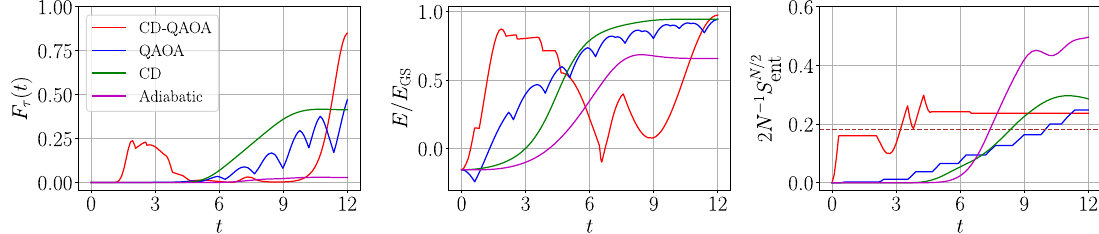
FIG. 24. Spin-1 Ising model: time evolution generated by the four different methods — CD-QAOA (red line), conventional QAOA (blue line), CD driving using the variational gauge potential (green line), and adiabatic evolution (magenta line). Three quantities are shown: the many-body fidelity (left panel), energy (middle panel), and entanglement entropy of the half chain (right panel). The protocols correspond to the empty symbols during T ¼ 12 in Fig. 7. The horizontal dashed line in the entanglement entropy curve shows the value in the target state. The CD-QAOA protocol sequence is given in Table V. The model parameters are the same as in Fig.